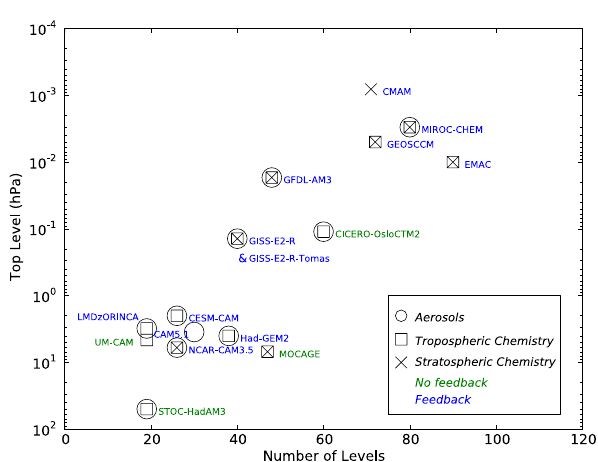
Figure 4. Vertical extent and number of levels for each ACCMIP model. In addition the representation of tropospheric chemistry, stratospheric chemistry and tropospheric aerosols is indicated by the combination of symbols. Note that, for clarity, CESM-­‐CAM has been displaced upward but should be overlapping NCAR-­‐CAM3.5. Feedback refers to the impact of explicitly resolved chemical species on radiation and therefore the simulated climate (see text for details).